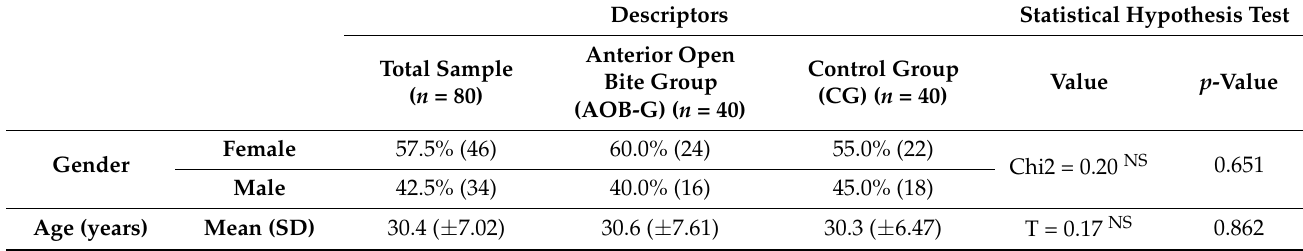
Table 1. Sociodemographic characteristics of anterior open bite patients and controls ( n = 80).